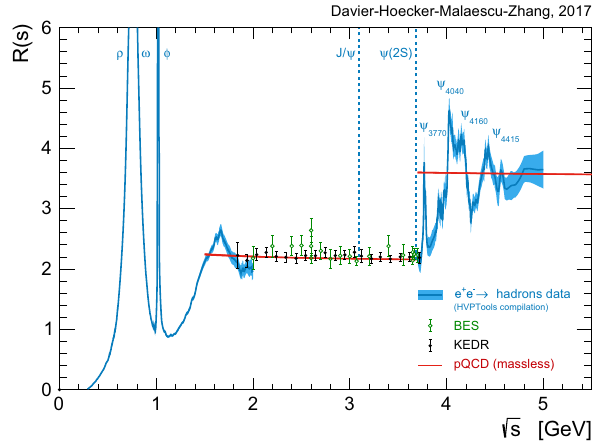
Fig. 10 The total hadronic e + e − annihilation rate R as a function of √ s . Inclusive measurements from BES [46–49] and KEDR [50,51] are shown as data points, while the sum of exclusive channels from this analysis is given by the narrow blue bands . Also shown is the prediction from massless perturbative QCD ( solid red line ) the references therein), and electroweak effects, 15 . 36